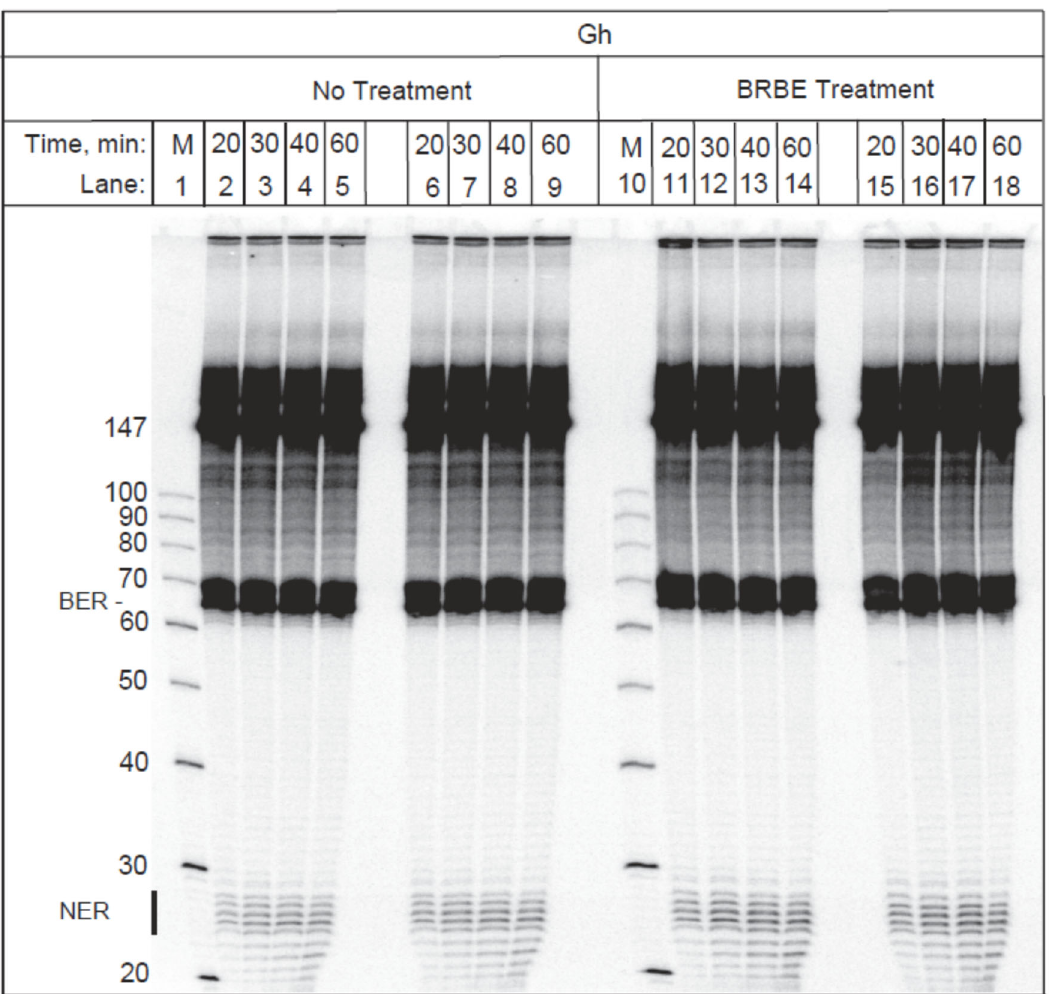
Figure 2. Gh substrate. Gel electrophoresis image of single guanidinohydantoin lesions (Gh) embedded in 147-mer DNA duplexes incubated in extracts from intact HeLa cells pre-treated or untreated with BRBE as a function of incubation time. The positions of the NER excision products are denoted by a vertical bar on the bottom left side of the